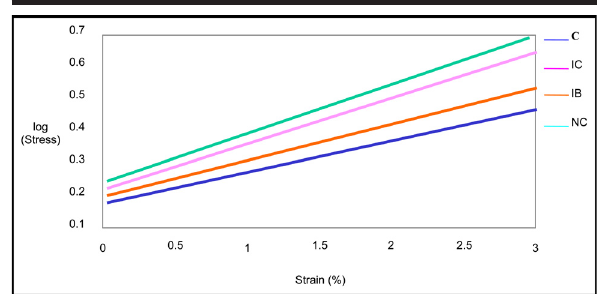
FIGURE 4 - Graphic representation of log/stress-strain an